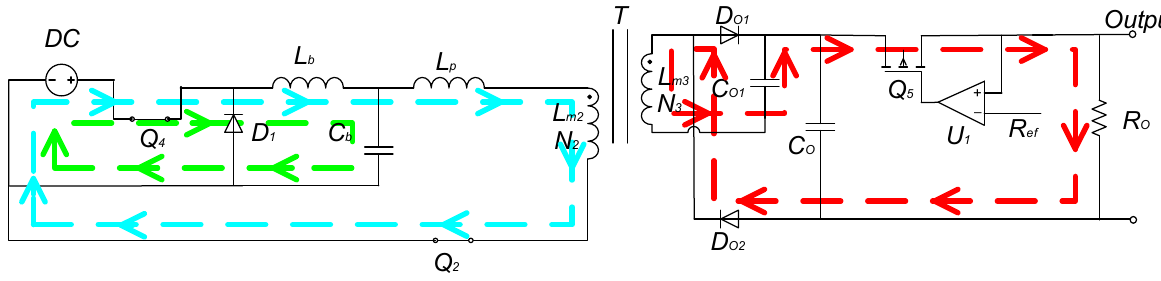
Figure 7. The equivalent circuit diagram when Q 2 is turned on. When the transformation enters the steady state, the ratio of input and output voltage is: